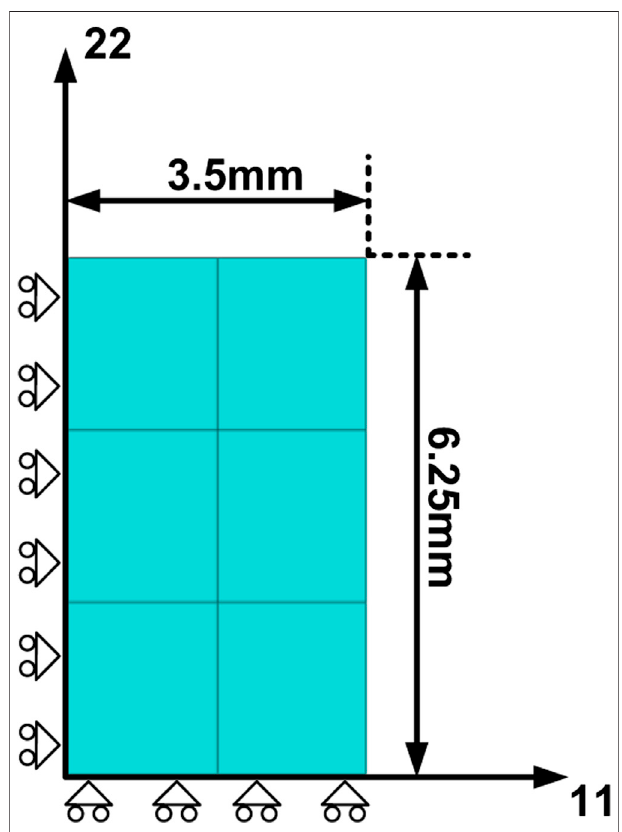
FIGURE 5 | FE model for damage imitation and evolution in